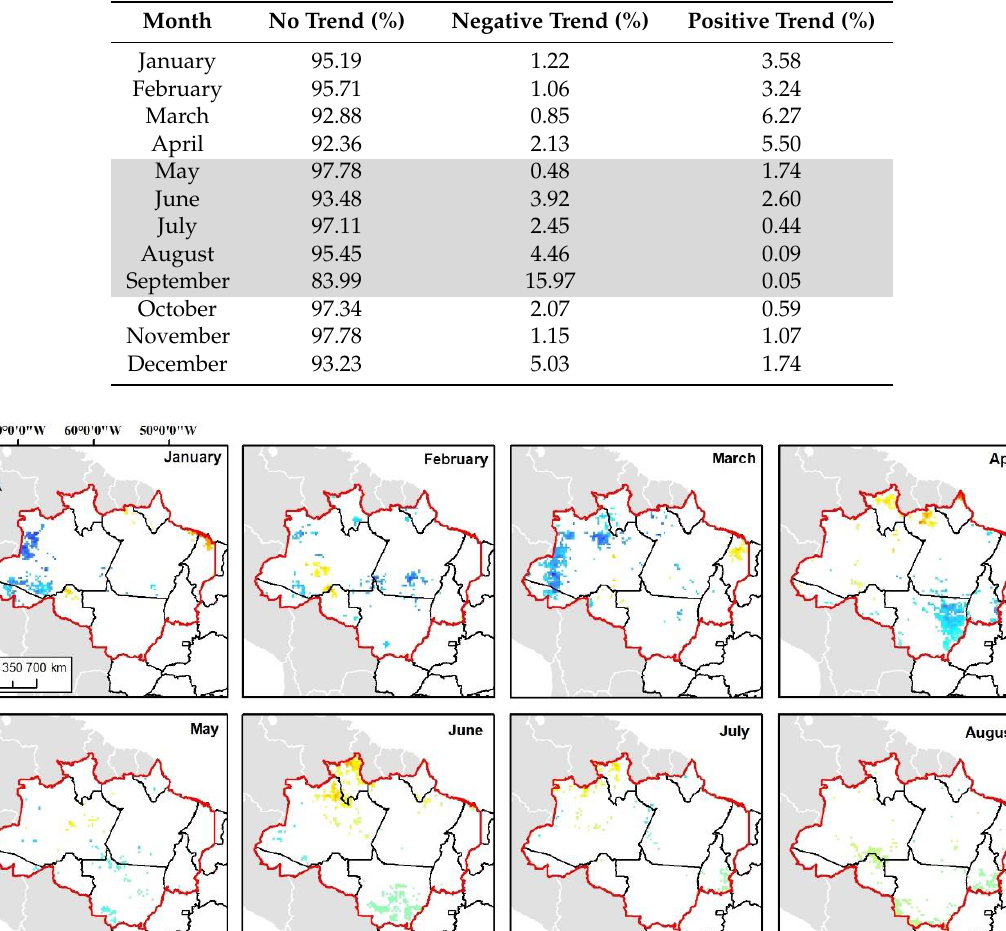
Table 2. Proportion of pixels with no tendency and with negative and positive significant trends over the months. The shaded months represent the dry season in the Amazon region (mean monthly precipitation less than 100 mm) [66].